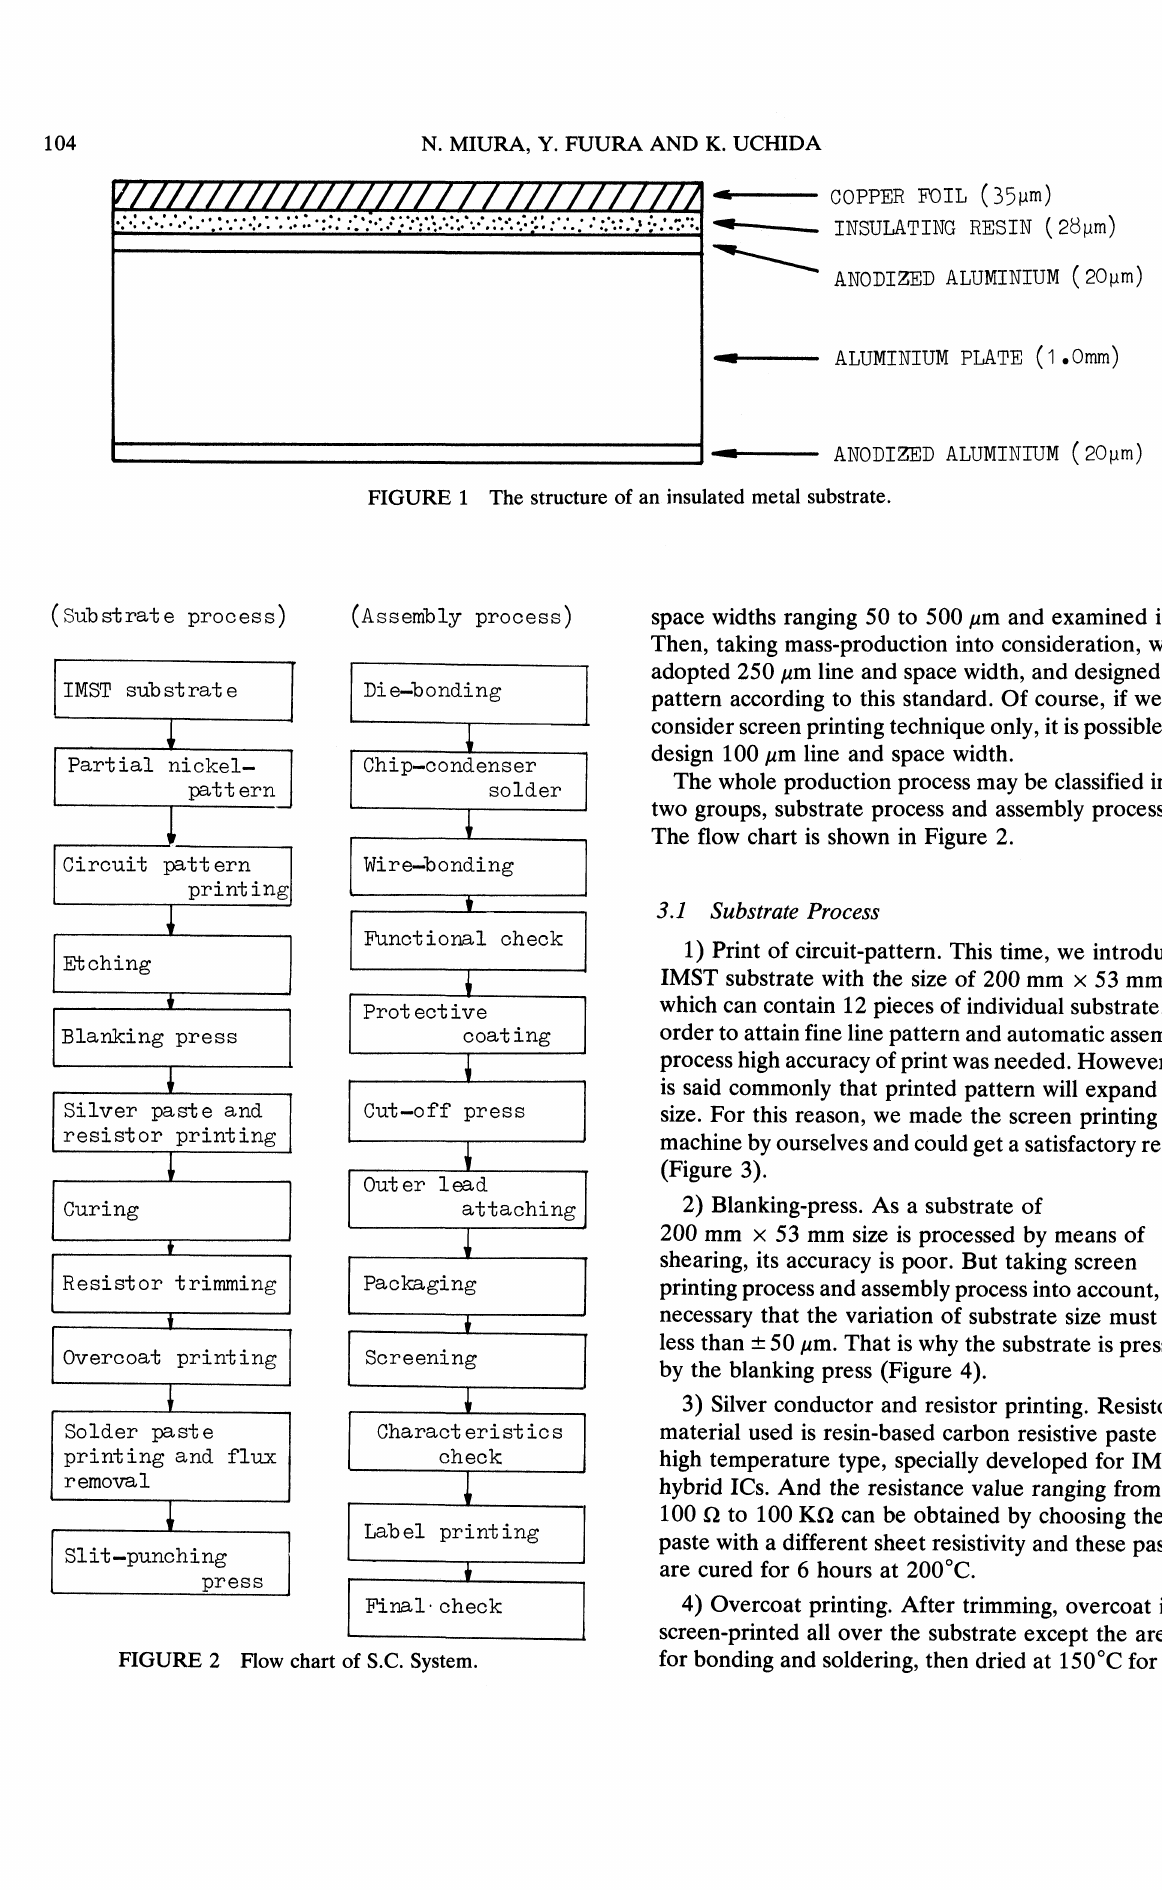
FIGURE 2 Flow chart of S.C.